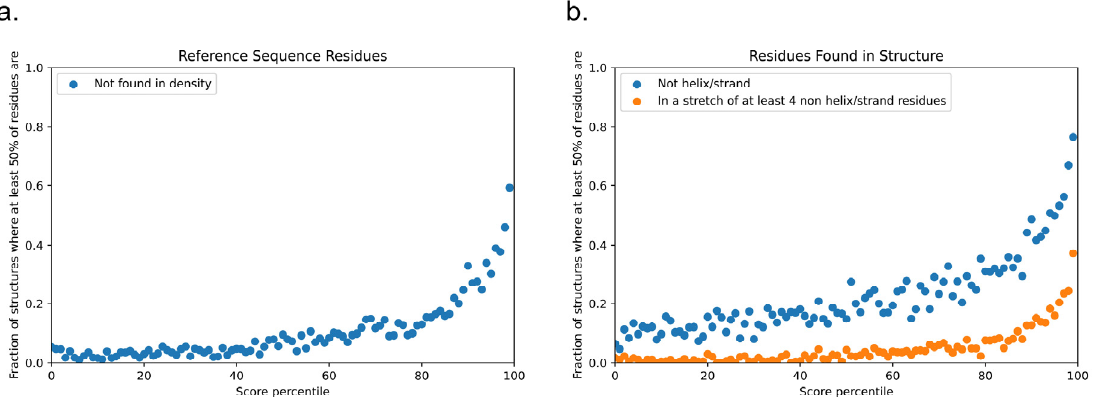
Figure 13. Disordered character of PDB sequences according to the LLPhyScore of chain reference sequences. Panel ( a ) shows the fraction of proteins in each percentile bin of LLPhyScore for which more than 50% of the reference sequence is missing from density (protein sequence that does not show up in the structure). Panel ( b ) shows the disordered/irregular structural character of residues that are within the density in the structure, with blue showing the fraction of proteins in each percentile bin for which more than 50% of the observed residues have a DSSP assignment other than helix or strand, and orange shows the fraction for which more than 50% of such residues are found in stretches of at least four residues in length with no helical or sheet